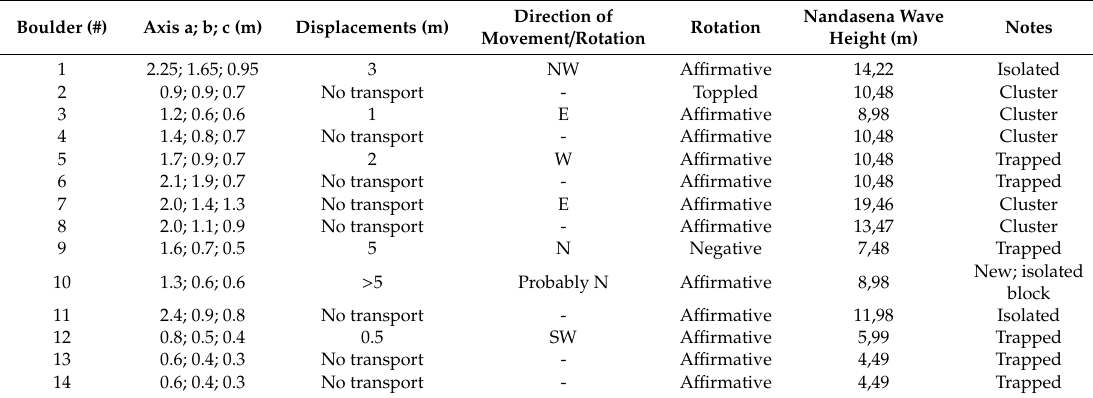
Table 2. List of boulders moved or rotated by the storm.